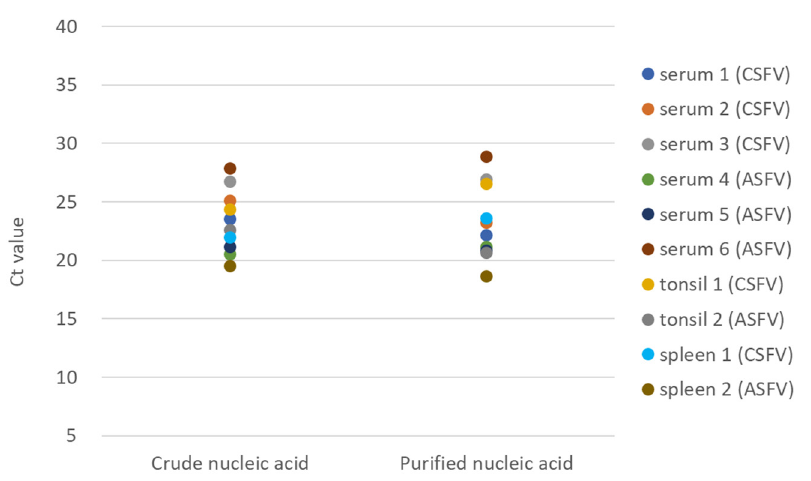
Figure 2. Comparison of the analytical sensitivities of ASFV and CSFV from crude nucleic acid and purified nucleic acid. The sera and tissue homogenate samples obtained from field cases in wild boar and experimentally infected pigs which had been defined as positive using the CSFV/ASFV multiplex rRT-PCR were analysed to evaluate the analytical sensitivities between crude and purified nucleic acid. Sera 1–6 were obtained from wild boar, ID: 1, 3, 4, 2002-2 (4 days post-infection; dpi), 2002-3 (13 dpi), and 2002-5 (9 dpi), respectively, as listed in Tables 1 and 2. The tonsil and spleen samples were obtained from wild boar, ID: IS-633 and 2101-2, respectively.